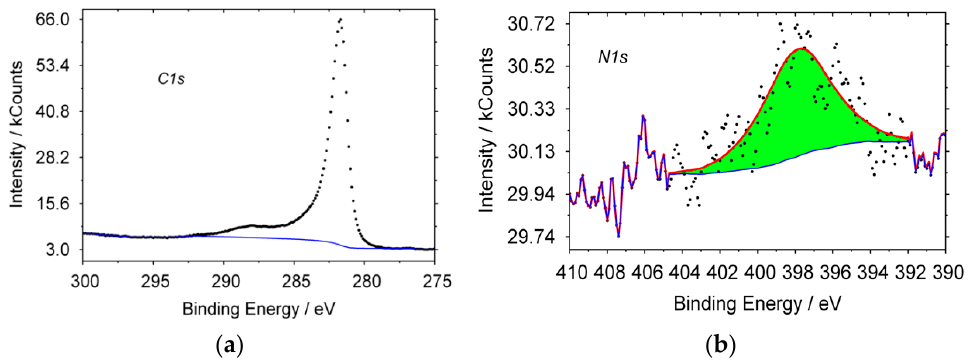
Figure 1. Typical XPS spectra for CNT, synthesized from propane: ( a ) carbon, ( b ) nitrogen. XPS spectra (N 1s ) of samples with different ammonia content in the initial gas mixture